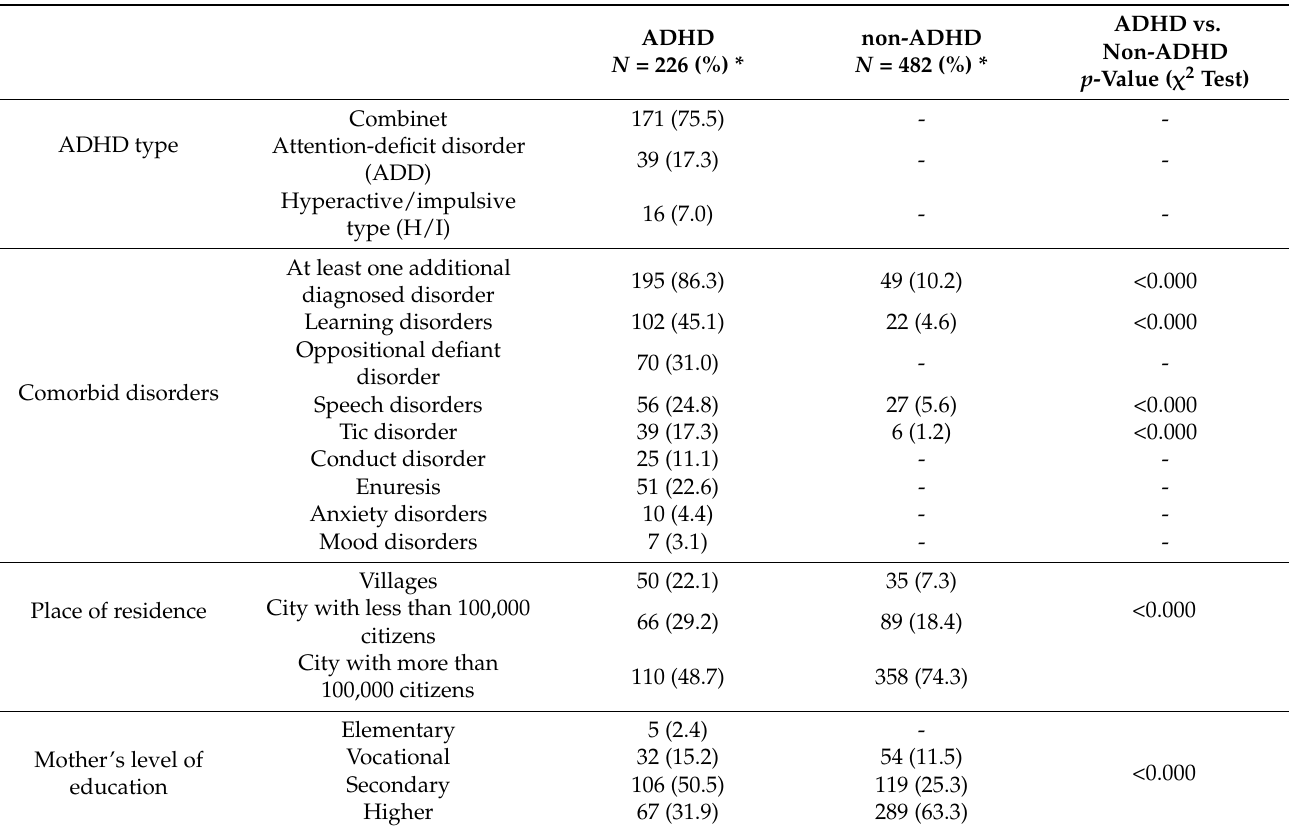
Table 2. Characteristics of the